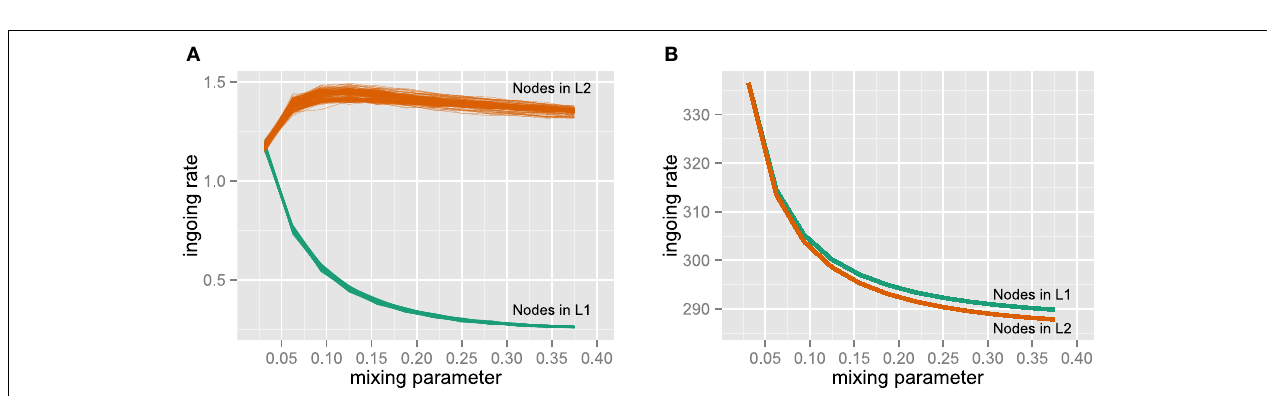
horizontal axis corresponds to the mixing parameter. For the paths that only use a single layer, we divide the contribution between paths where the source and target nodes are within the same community and in different communities. There are no intracommunity paths that use both layers.